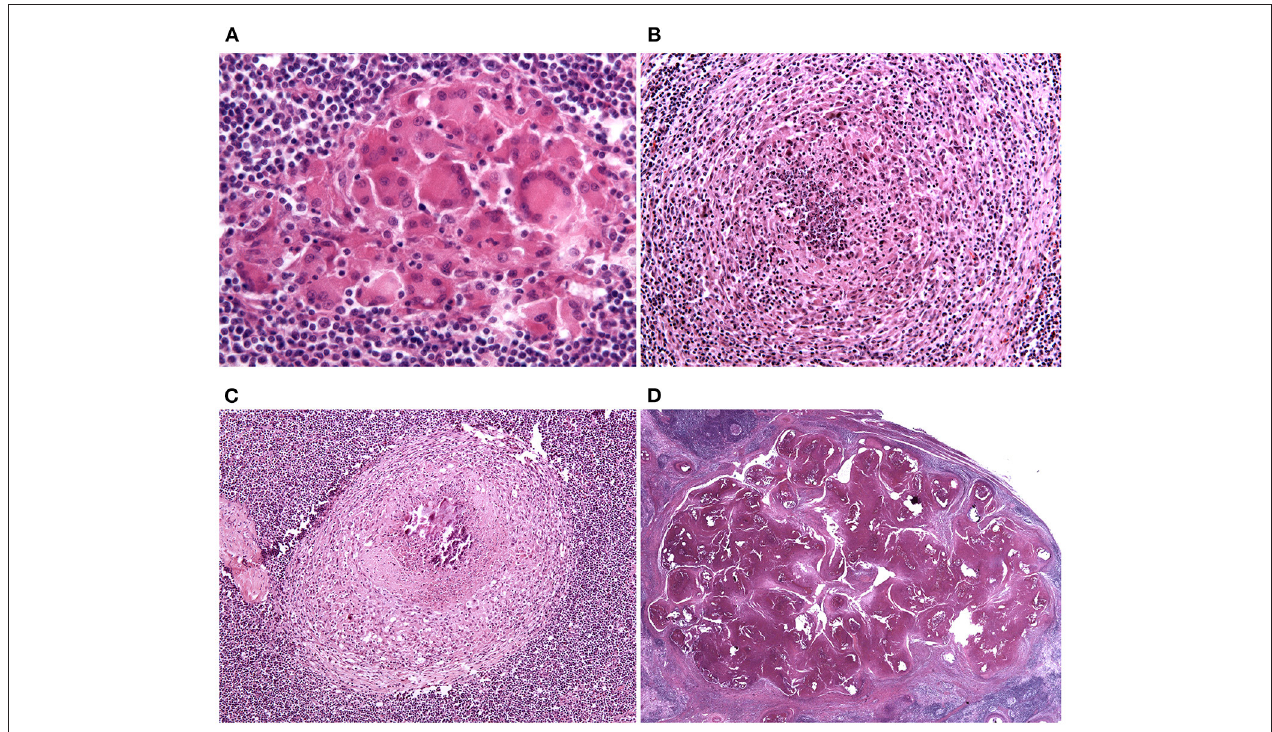
FIGURE 1 | Lymph node, granuloma maturational stages. (A) Stage 1 (initial) granulomas are composed of an unencapsulated cluster of epithelioid macrophages. HE stain, 40 × . (B) Stage 2 (solid) granulomas are enclosed partly or entirely by a thin capsule and a minimal necrotic core, composed of necrotic inflammatory cells, is sometimes visible. HE stain, 20 × . (C) Stage 3 (minimal necrosis) granulomas are fully encapsulated and a central necrotic core, composed of a variably mineralized caseous material, is present. HE stain, 10 × . (D) Stage 4 (necrosis and mineralization) granulomas are multicentric, thickly encapsulated, with abundant and extensively mineralized caseous necrosis. HE stain, 0.80 ×